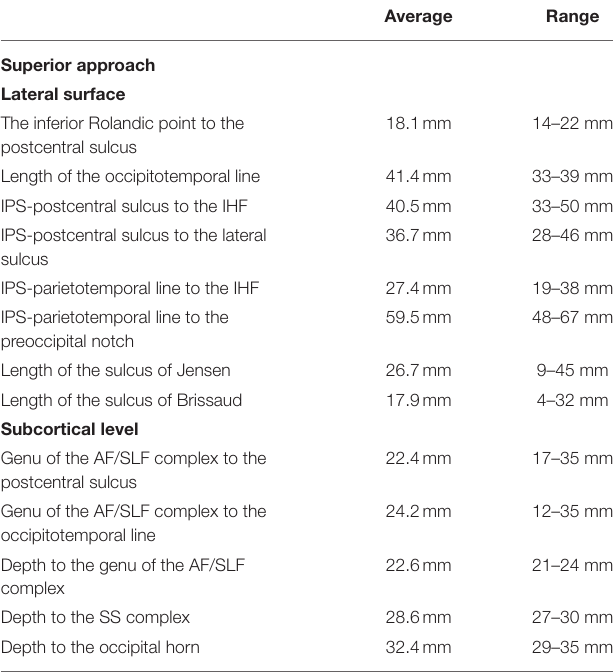
TABLE 1 | Measurements related to the lateral